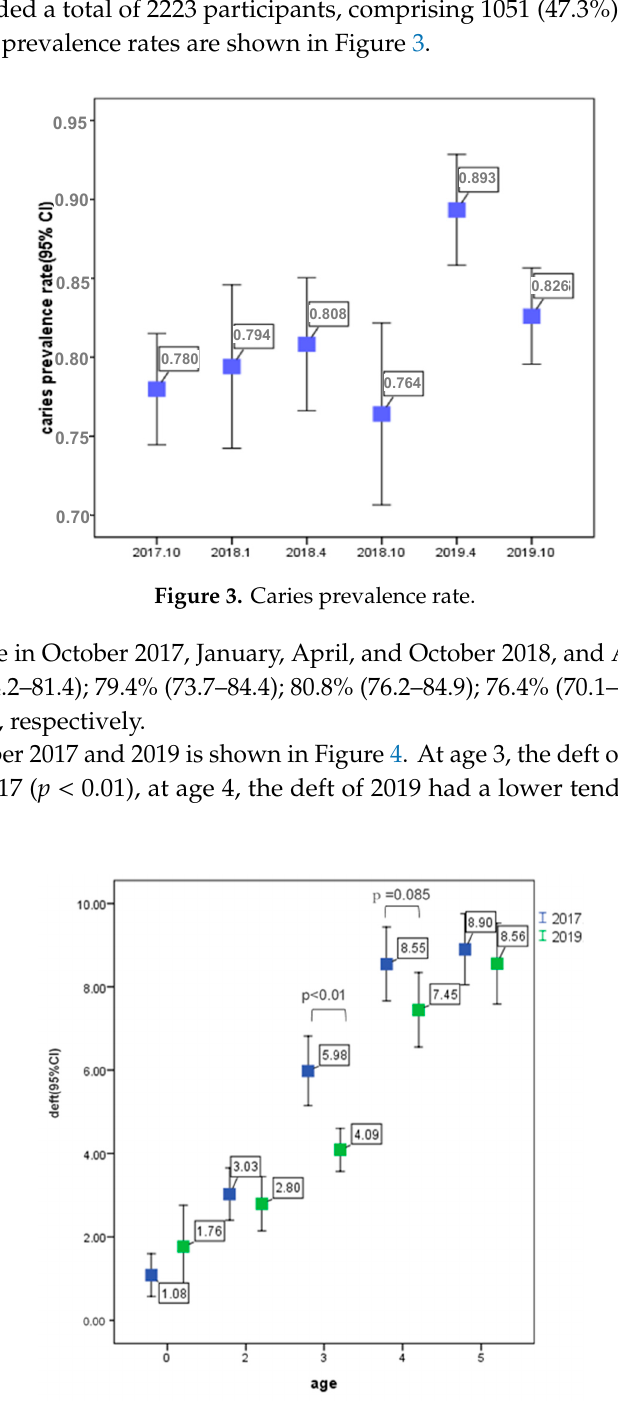
Figure 4. deft in October 2017 and 2019.